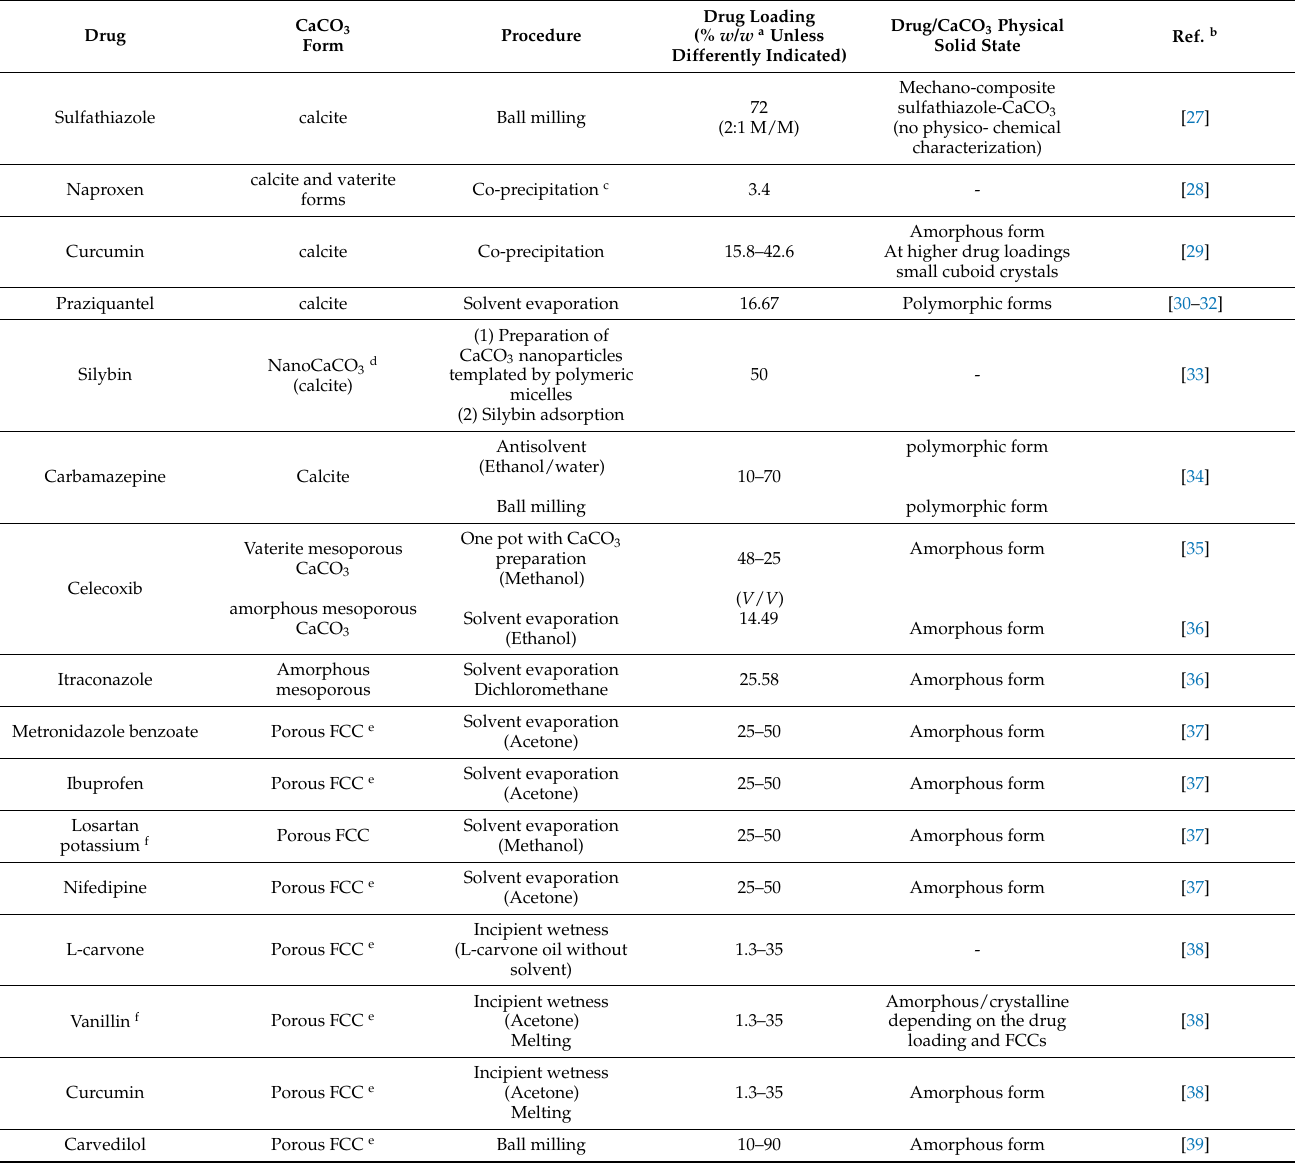
Table 1. Methods for obtaining carbonate-drug composites and main